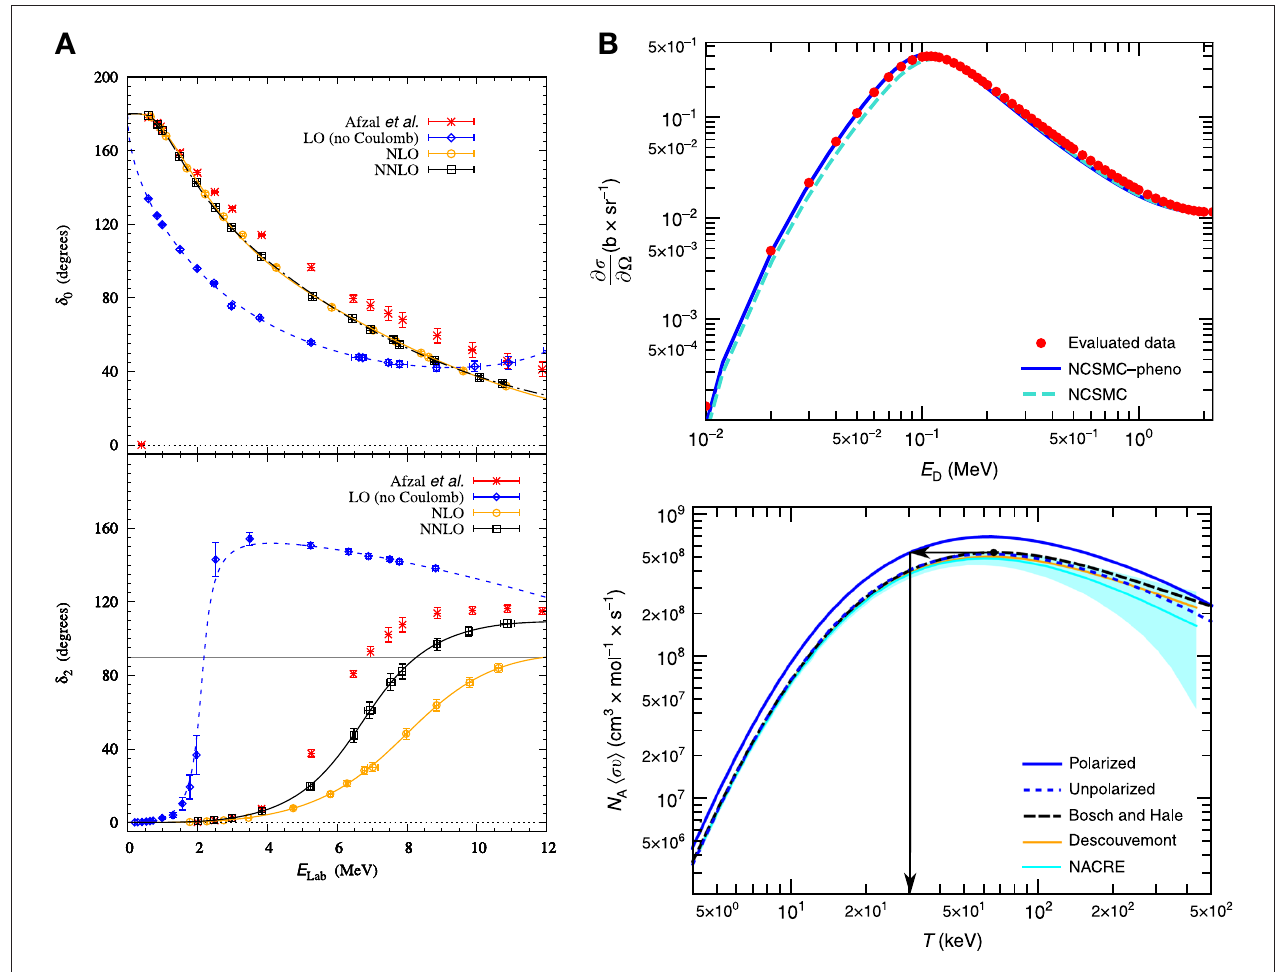
FIGURE 12 | Ab initio calculations of nuclear reactions. (A) S ( δ 0 ) and D -wave phase shifts ( δ 2 ) for α - α scattering at various orders in Lattice EFT. For details, see references [ 179, 180]. Figure courtesy of S. Elhatisari. (B) NCSMC results for the deuterium-tritium (D–T) fusion cross section (top) and reaction rate (bottom). The figure compares the rates for unpolarized and polarized fuel, as well as rates obtained from widely adopted parametrization of the fusion cross section (see reference [ 252] for details). The arrows are included to the guide the reader’s eye (see text). Figure reprinted from Hupin et al. [252] under a CC BY 4.0